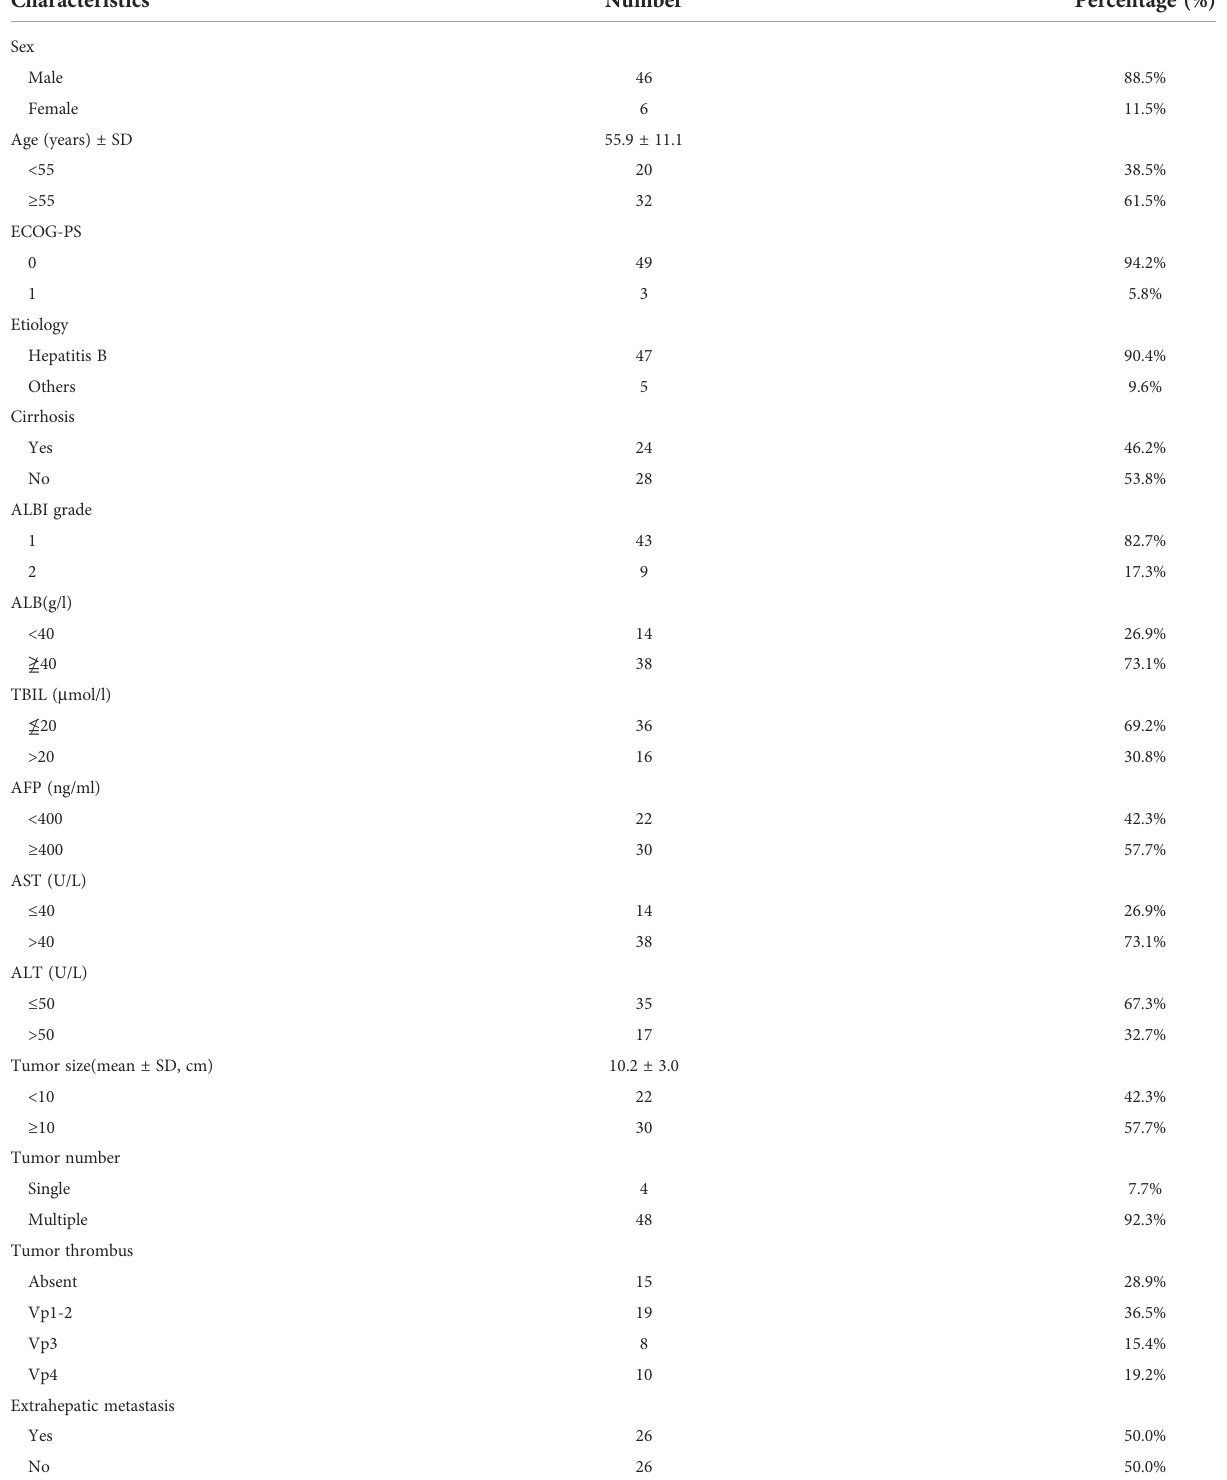
TABLE 1 Patient demographics and clinical